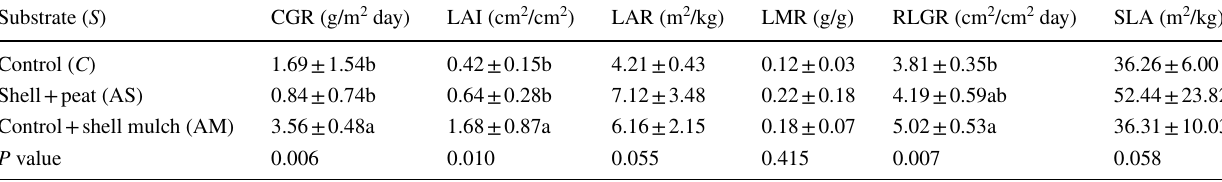
Table 2 Influence of the substrate on green bean plant growth parameters 60 days after sowing